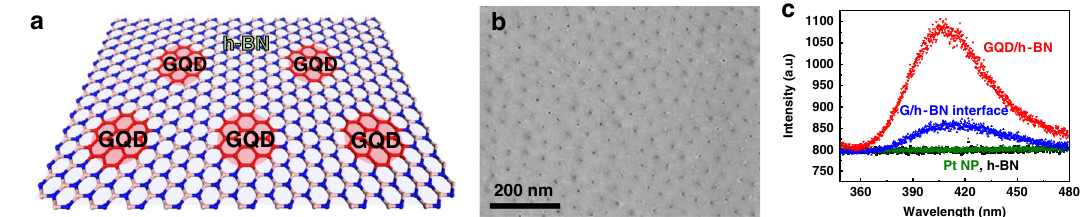
Fig. 2 PL analysis of GQD/h-BN in-plane heterostructures. a Schematic of the GQD/h-BN in-plane heterostructures fabricated by conversion of h-BN on Pt nanoparticles (Pt NPs). b SEM image of the GQD/h-BN heterostructures on a SiO 2 /Si substrate. c PL spectra of GQD/h-BN (red), Pt NPs (green), and bare h-BN (back). The PL spectrum of G/h-BN interface (blue) is the same spectrum as green one in Fig. 1d. All of samples were measured on a SiO 2 /Si substrate using 266-nm